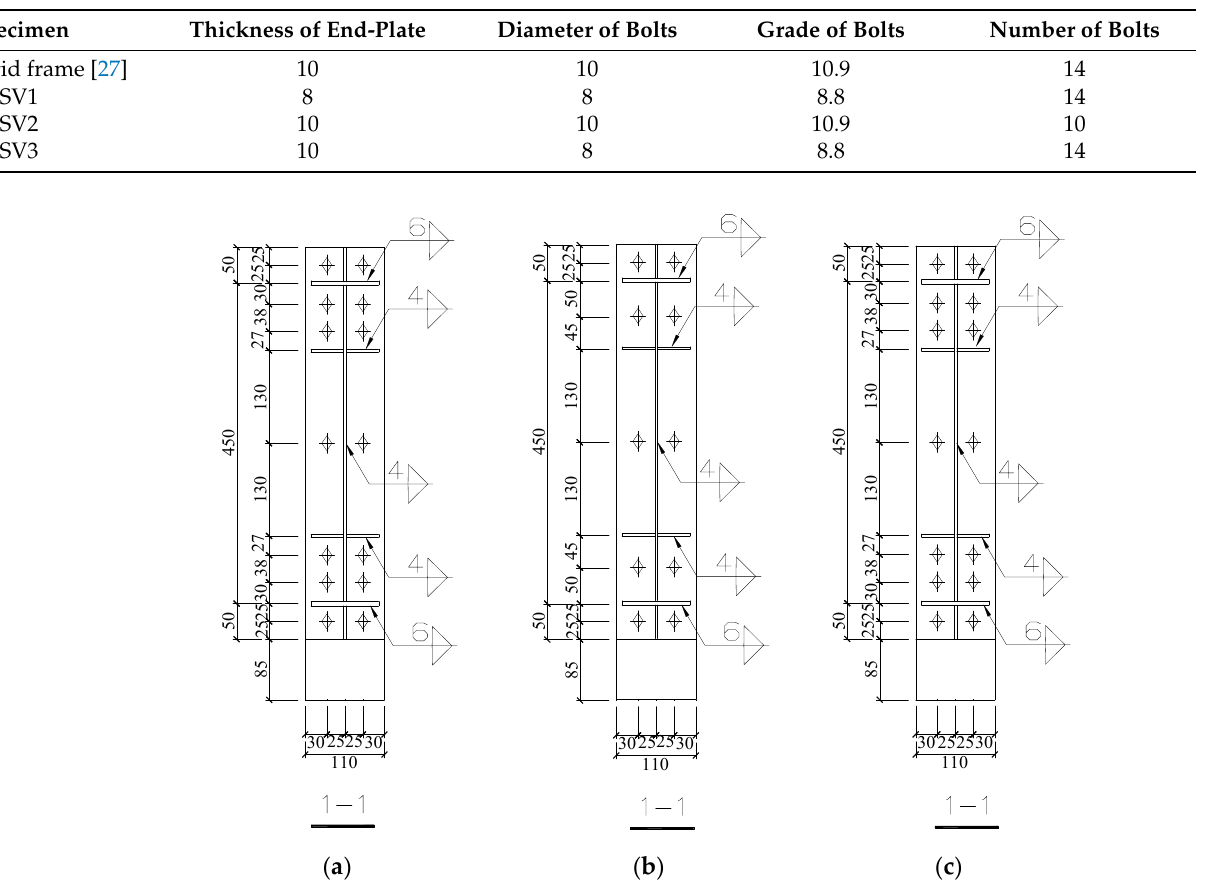
Figure 3. Arrangement of end-plate bolts. ( a ) SV1; ( b ) SV2; ( c ) SV3.